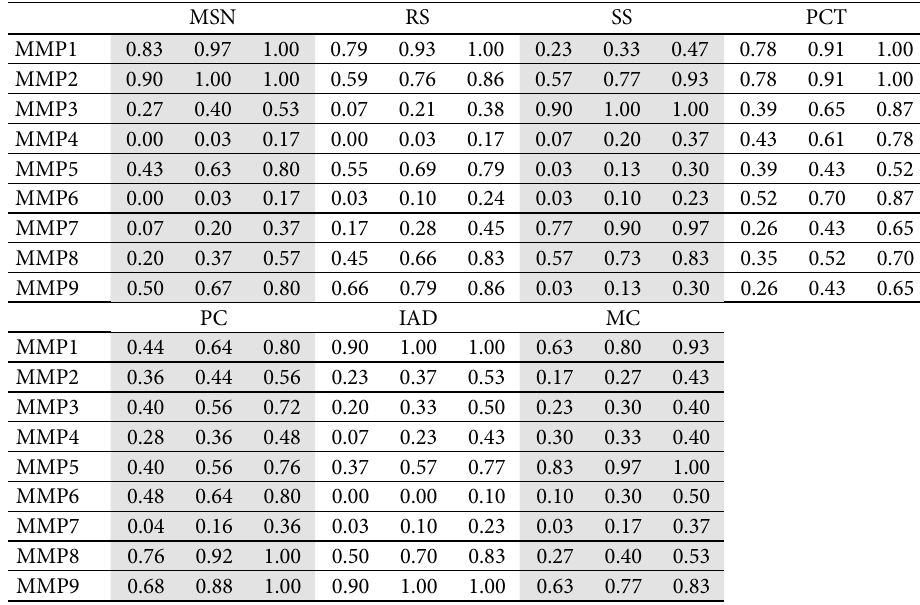
Table 10. The fuzzy normalized decision matrix